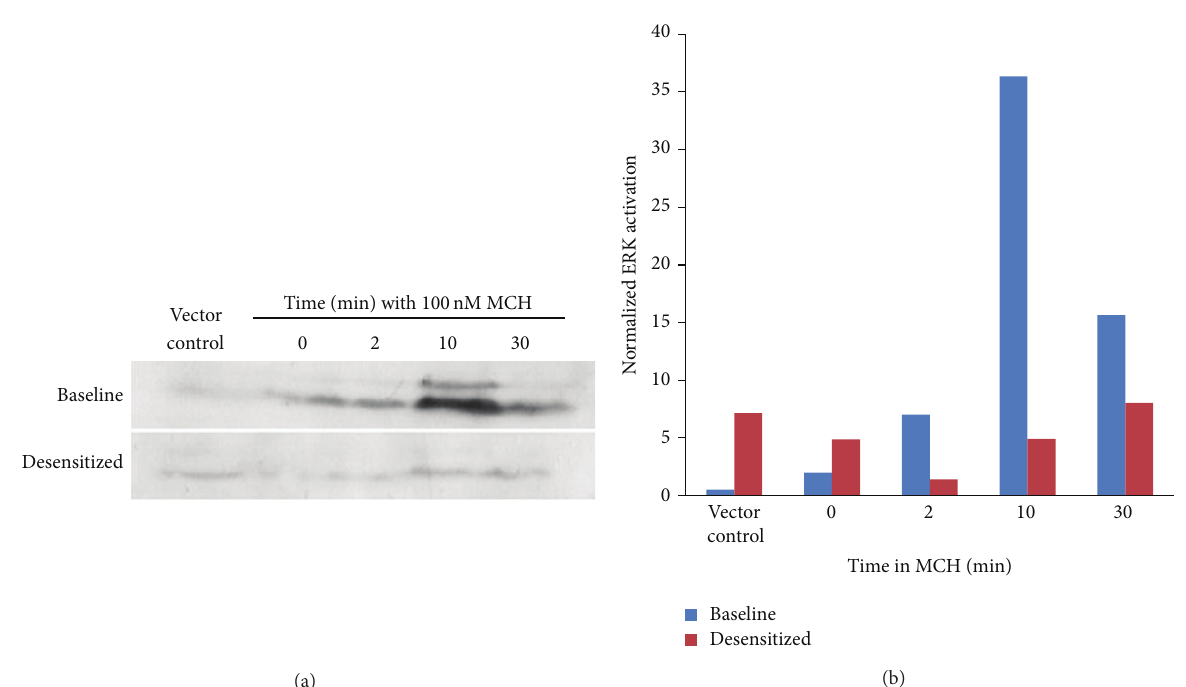
Figure 1: MCH-mediated ERK activation efficiently desensitizes. BHK-570 cells were transfected with plasmid DNA encoding MCHR1 an ERK activation assay performed on cells treated with MCH for up to 30min. A second set of dishes was treated for MCH for 15min and then subjected to a 30 min washout prior to the MCH time course (2nd exposure). (a) Cells were harvested in 2X Laemmli sample buffer, run on SDS-PAGE and western blots were performed with primary antibodies to phosphorylated and total ERK. (b) Densitometry was performed using NIH Image J Software where ERK activation was normalized against total ERK. Experiment shown is representative of three total